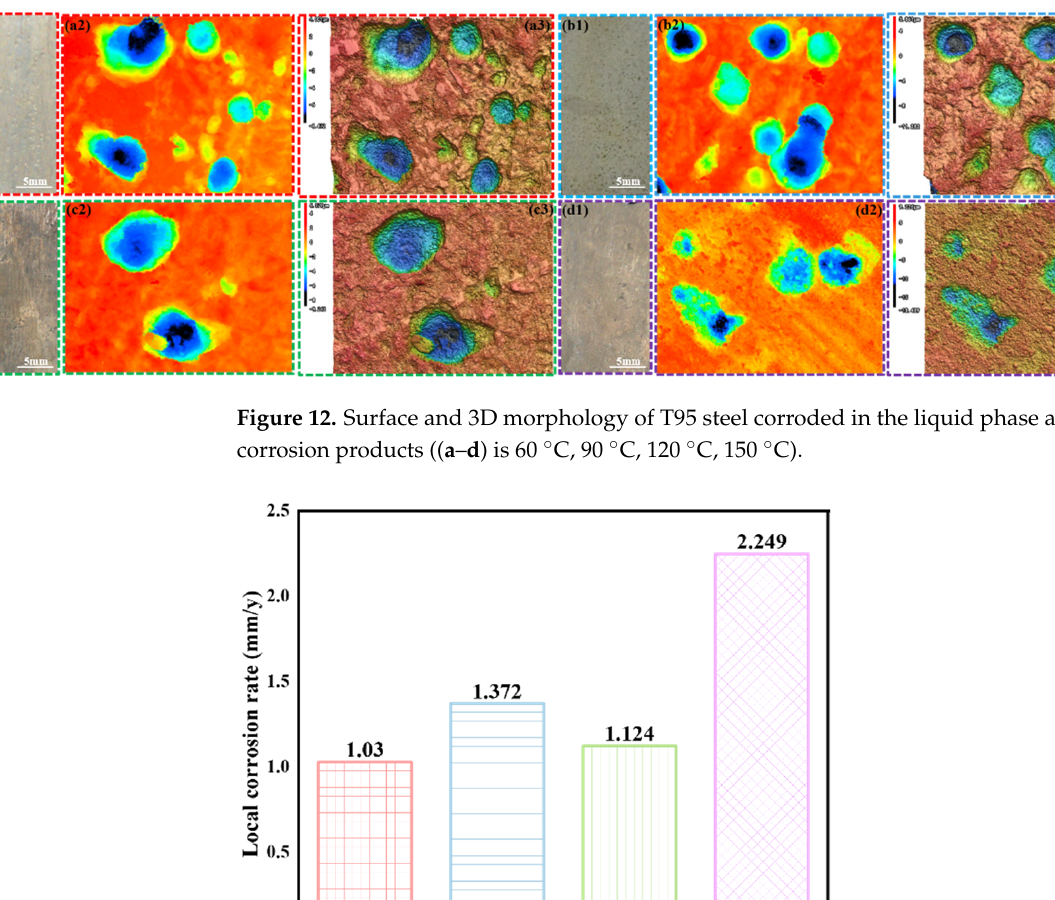
Figure 14. Element distribution in the pitting of T95 steel corroded in the liquid phase ( a ‐ d is 60 °C, 90 °C,120 °C,150 °C). 3.2.4. Phase Composition of Corrosion Products An X ‐ ray diffractometer was used to analyze the phase composition of the corrosion products of the corroded samples to obtain the XRD pattern. Jade software was used to